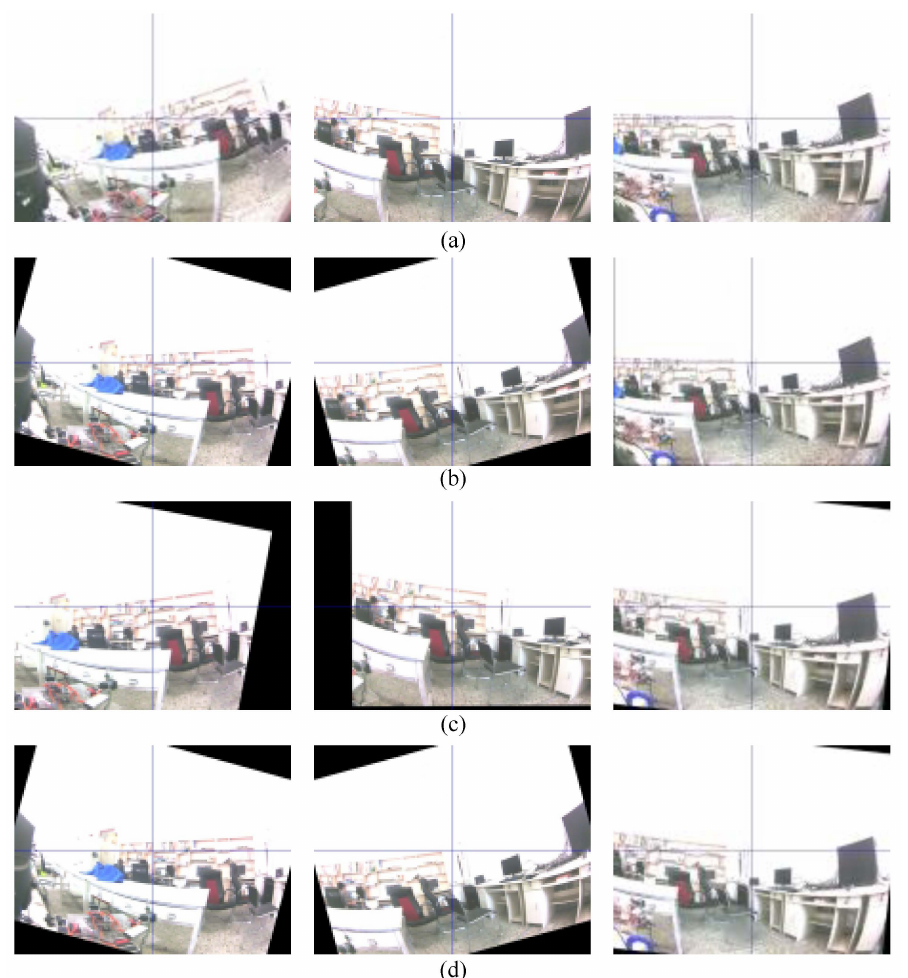
Figure 11. Sequence frame of the moving camera ( a ) is an original video (left: 48th, center: 168th frame, right: 227th frames); ( b ) Stabilized frame by an IMU-aided motion estimator; ( c ) Stabilized frame by a KLT tracker; and ( d ) Stabilized frame by a hybrid